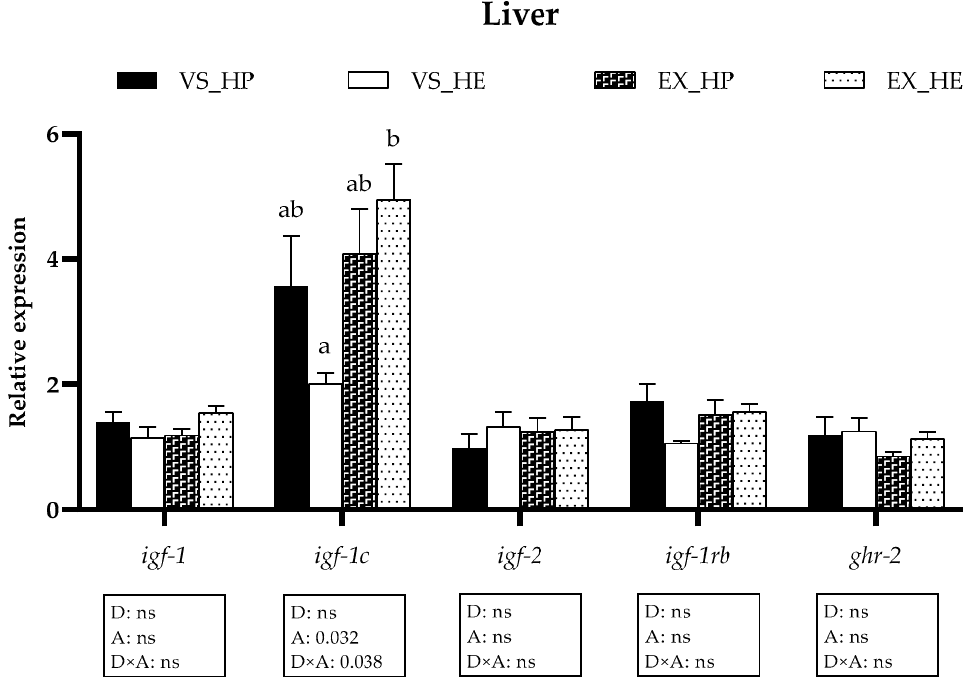
Figure 2. Relative gene expression of GH-IGFs axis members in liver of fish under voluntary swimming (VS) or sustained exercise (EX) and fed with the high-protein diet (HP) or high-energy diet (HE). Data are shown as means + SEM. VS, n = 12; EX, n = 16. Factorial statistical analysis was assessed by two-way ANOVA, and the p -values of factors diet (D), physical activity (A) and interaction (D × A) are displayed under graph. Different letters indicate significant differences (Tukey’s post-hoc test, p < 0.05).